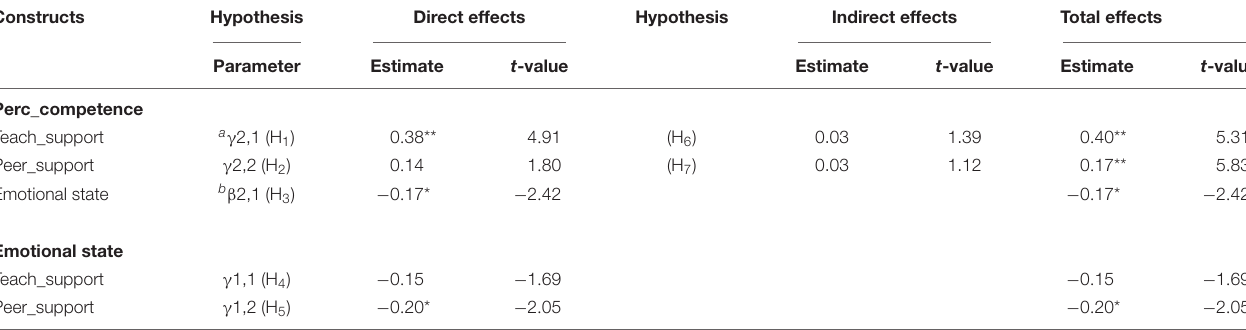
TABLE 4 | SEM model: direct and indirect relationships between teacher and peer support, emotional state, and perceived competence.